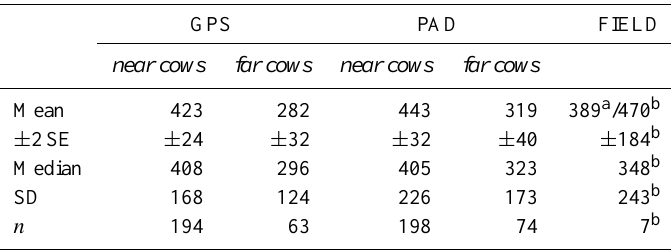
Table 2. Methane emissions calculated with known cow position (GPS) or occupied paddock area (PAD) for different distances of the cow herd to the EC tower (near, far), and calculated without using cow position information (FIELD). All values, except n, are in units g CH 4 head − 1 d − 1 .